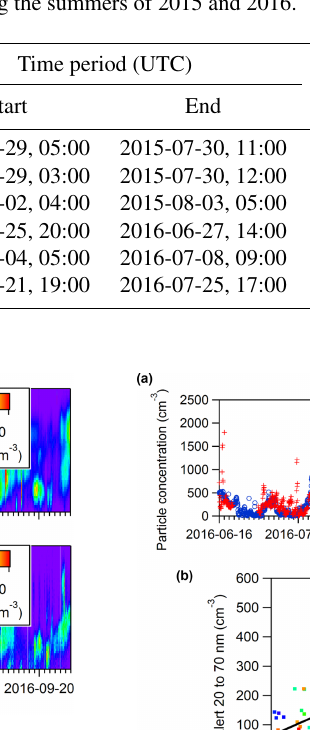
Table 1. Particle growth rates for five growth events during the summers of 2015 and 2016.